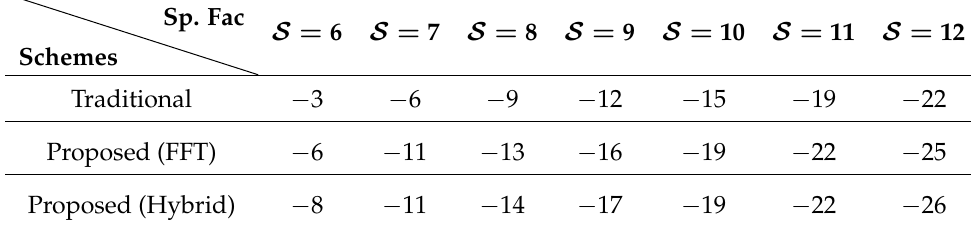
Table 2. SNR (in dB) threshold